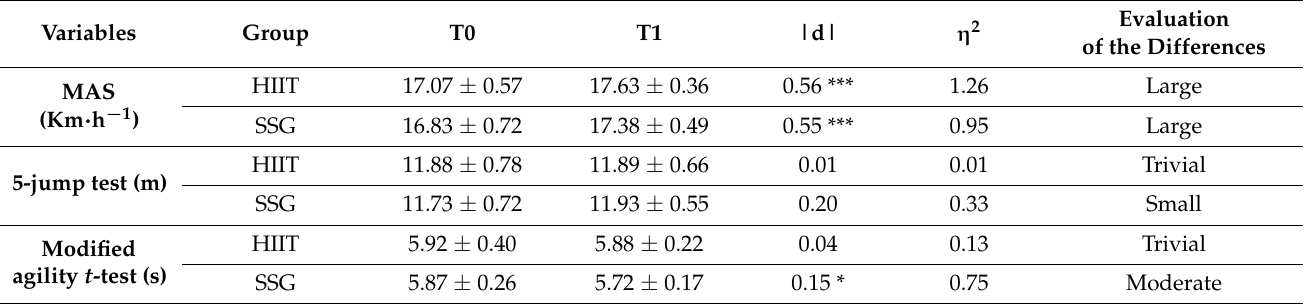
Table 5. Mean ( ± SD) values for physical performance variables for high intensity interval (HIIT) and small-sided games (SSG) training, measured before (T0) and after (T1) the six-week training